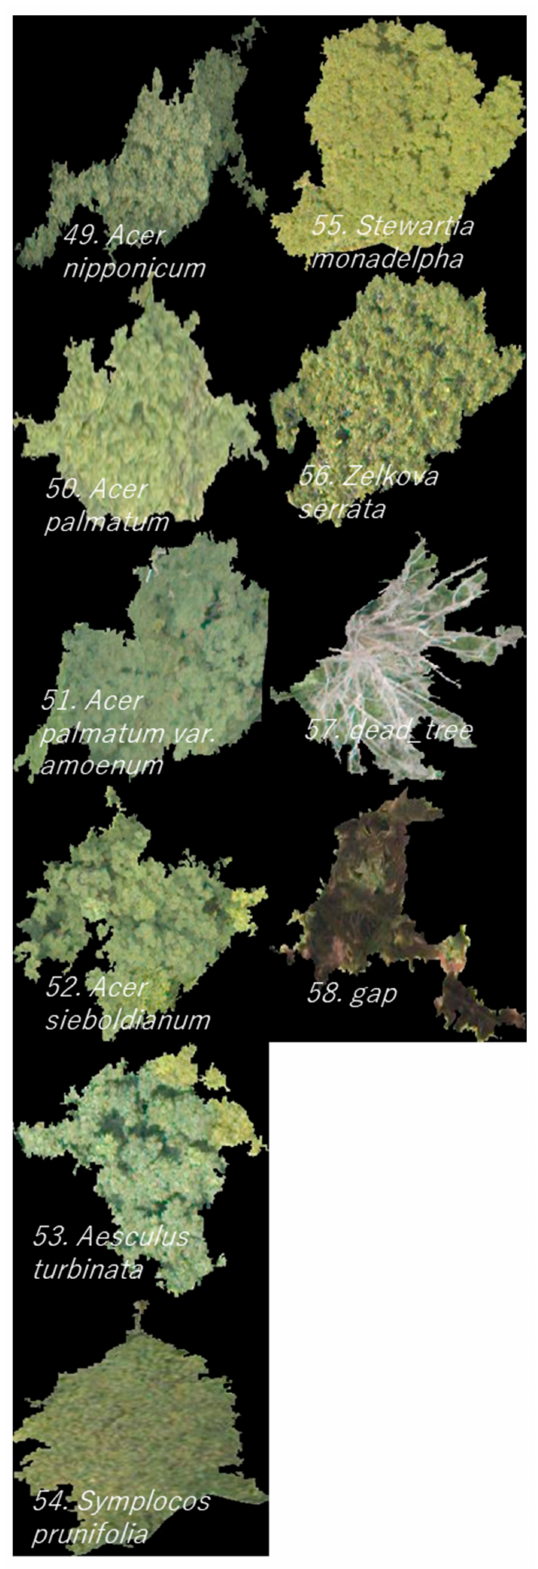
Figure 3. Tree crown images of each species taken by UAV from 100 m